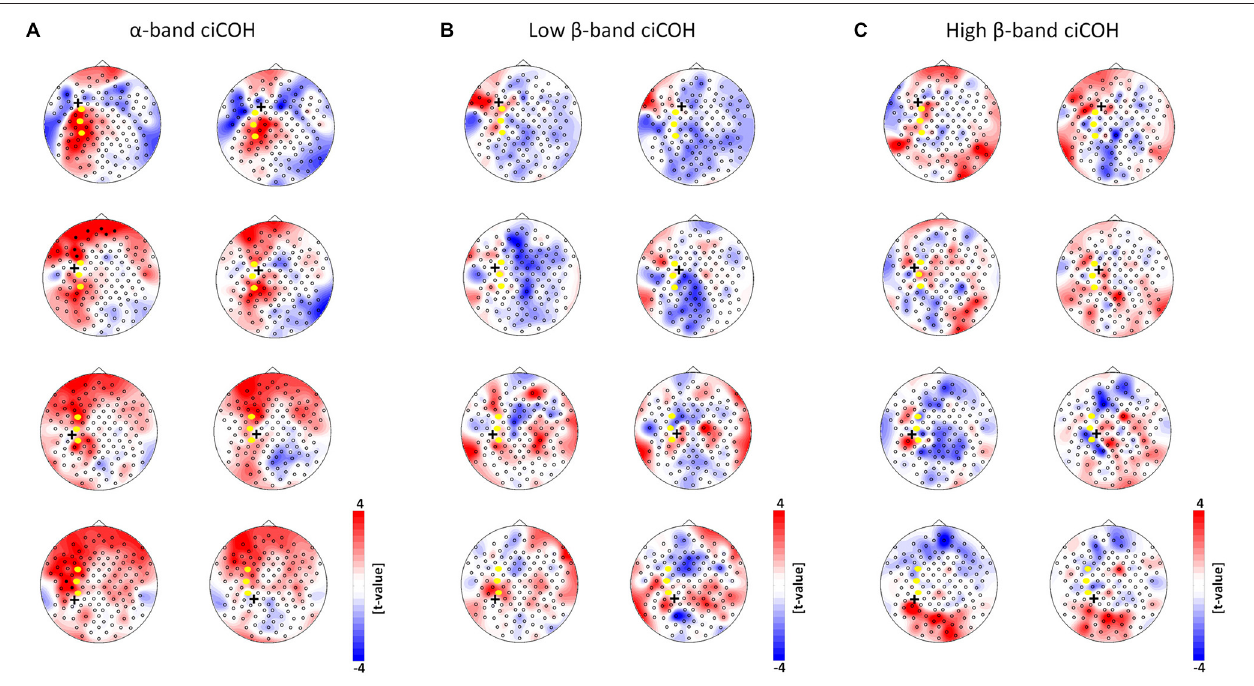
coded in yellow). Red represents increase in functional connectivity; blue represents decrease in functional connectivity. Note that no systematic significant differences for the α -, low and high β -band were observed. Only two significant clusters in two different seed electrodes were observed in the α